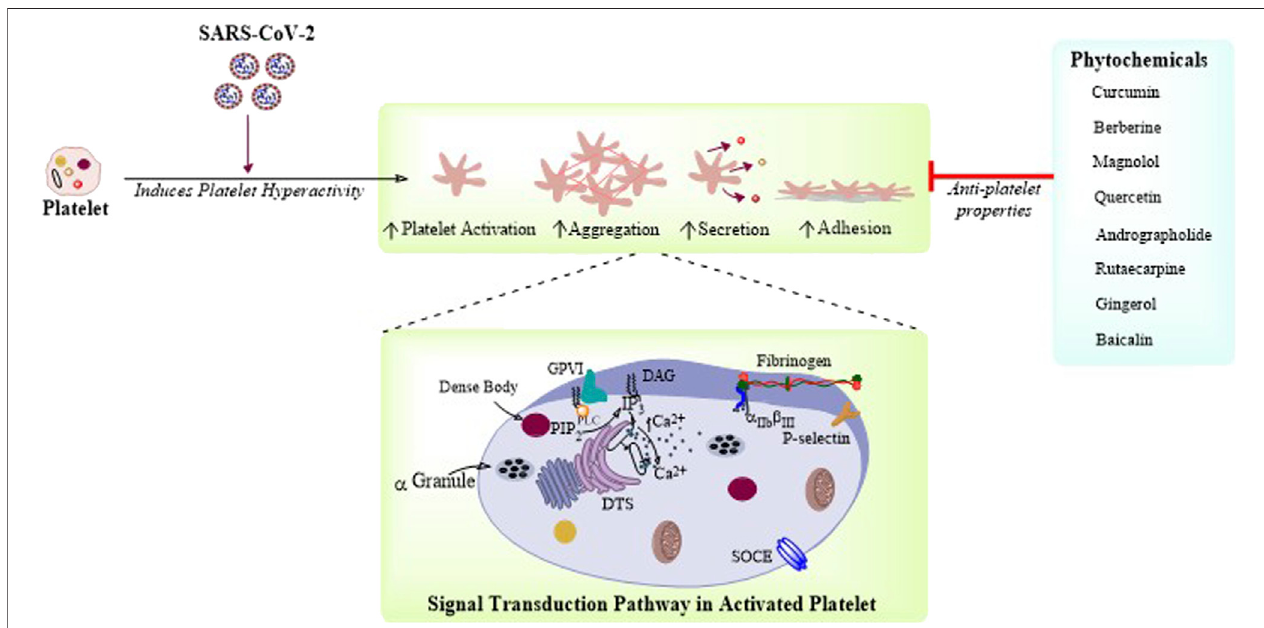
FIGURE 1 | Phytochemicals targeting platelet function and thrombosis: Platelet function is governed by intracellular Ca 2+ signaling resulting in platelet adhesion, activation, aggregation, and secretion. SARS-CoV-2 is demonstrated here to cause increased platelet activation, secretion, and aggregation. There are few phytochemicals which are reported to have antiplatelet activity and could be potential therapeutic candidates for the treatment of COVID-19.